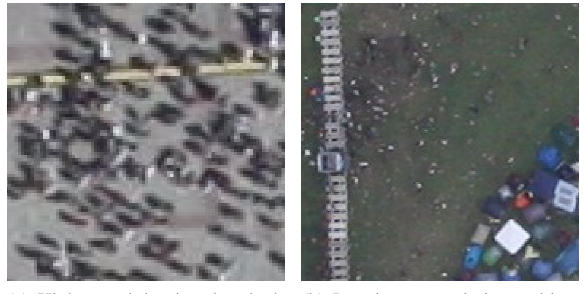
Figure 1: Examples of 64 × 64 image patches containing human